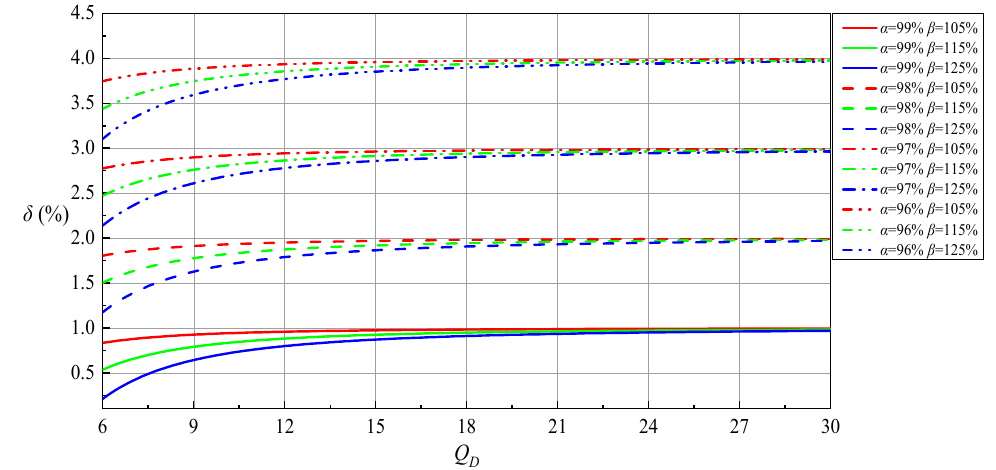
Figure 3. The relationship between the percentage variation of the detection coil impedance δ and the quality factor Q D .